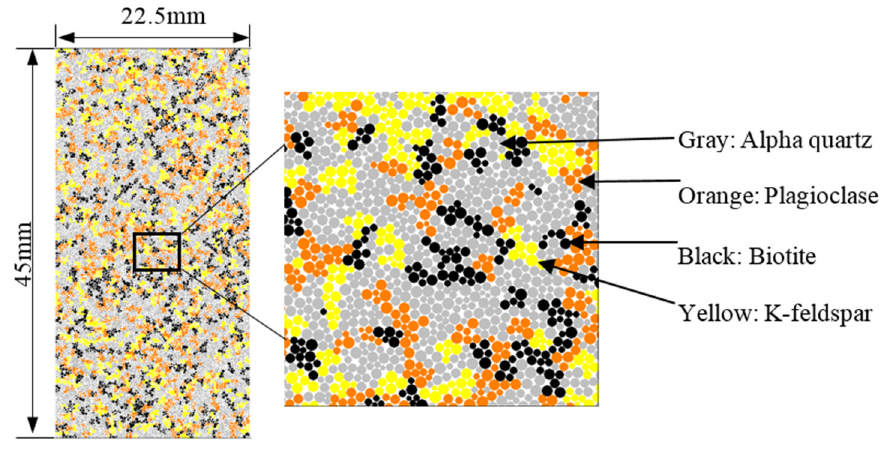
Figure 2. Numerical specimen of Strathbogie granite built in particle flow code in two dimensions (PFC 2D ).